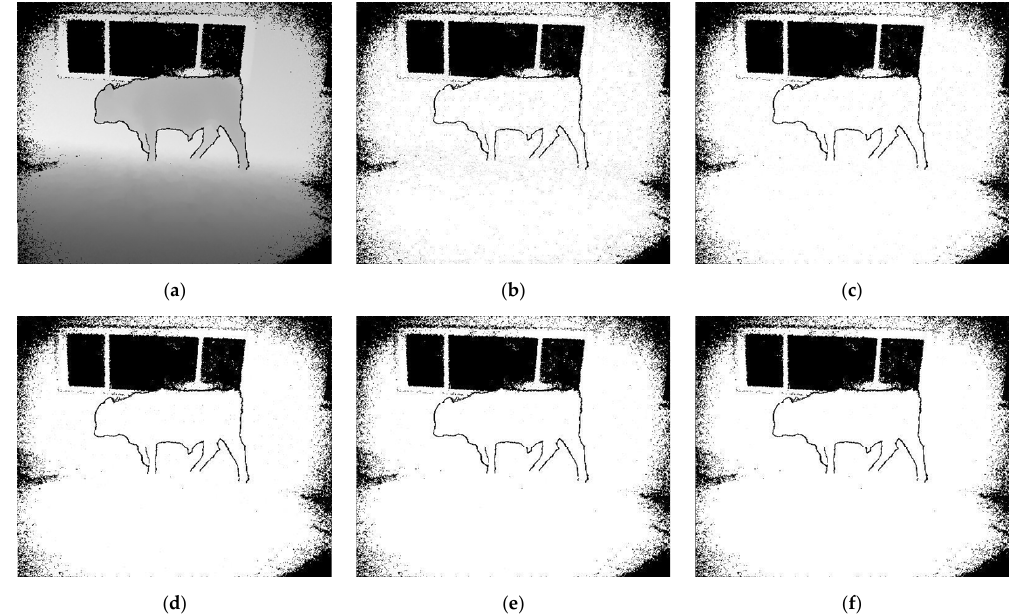
Figure 8. Pseudo images of depth image processed by the depth density algorithm. We set the size s to 3, 5, 7, 9, and 11, respectively. The value range of the depth density range is [0, 1]. ( a ) The original depth image. ( b ) The pseudo image of depth density (s = 3). ( c ) The pseudo image of depth density (s = 5). ( d ) The pseudo image of depth density (s = 7). ( e ) The pseudo image of depth density (s = 9). ( f ) The pseudo image of depth density (s = 11).